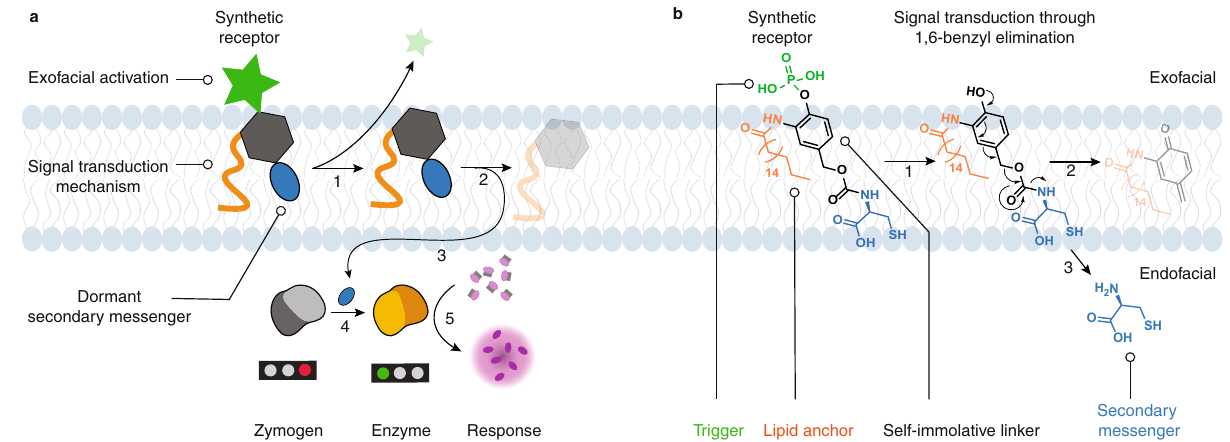
Fig. 1 | Schematic and chemical illustration of the proposed concept of trans- membrane signaling using our synthetic receptors. a Schematic showing (1) receptor activation at the exofacial side of the membrane, (2) self-immolation and ensuing generation of the secondary messenger, which (3) enters the inner com- partment (4) and activates the chemical zymogen; (5) leading to a secondary sig- naling event and signal ampli fi cation via enzymatic catalysis. b Speci fi c chemistry